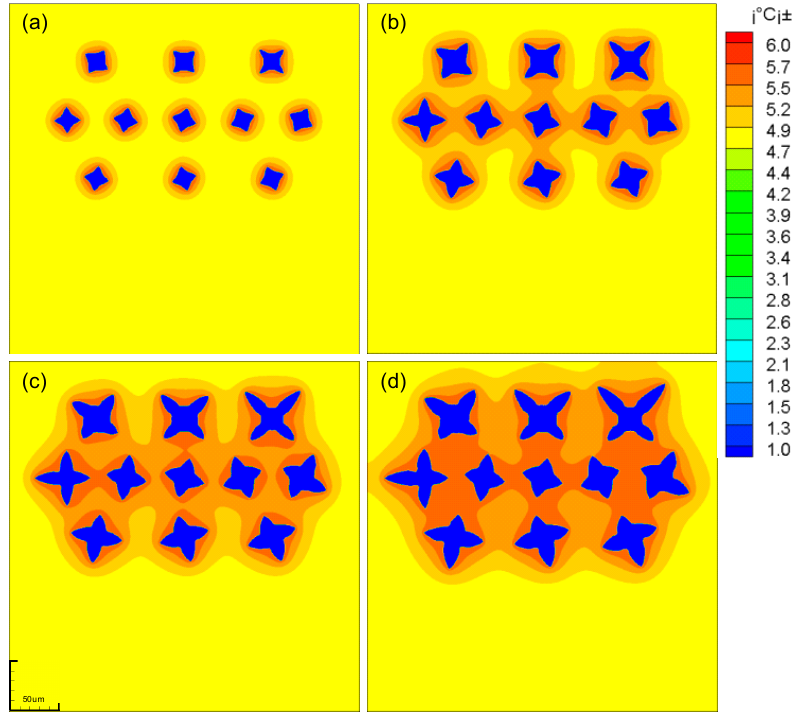
Figure 11. The evolution and concentration distribution of dendrites without motion. ( a ) t 1 = 200; ( b ) t 2 = 500; ( c ) t 3 = 800; ( d ) t 4 = 1000.